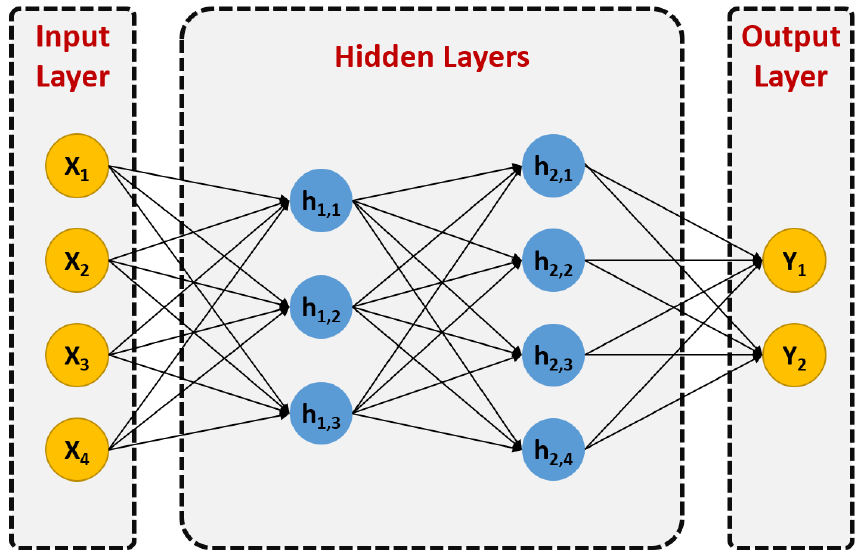
Figure 3. Simple neural network